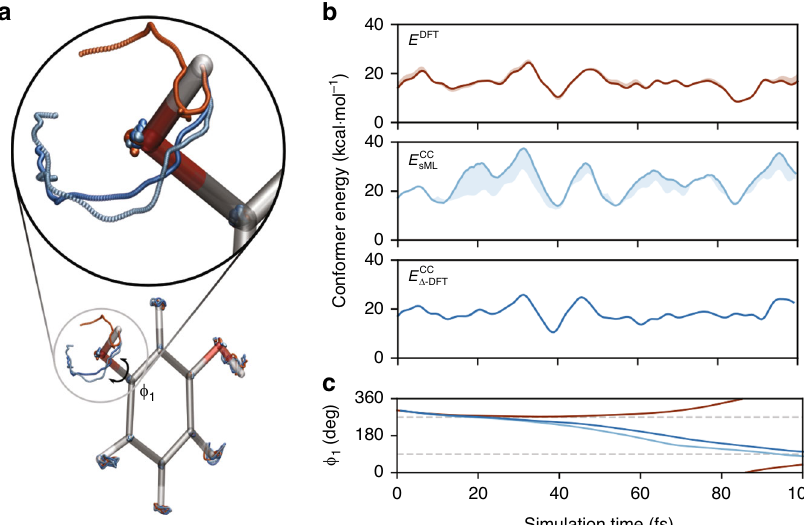
Fig. 3 Resorcinol dynamics from an initial condition near a conformational change. a The atomic positions explored during 100 fs NVE MD trajectories ½ n DFT (cid:3) with RESPA-corrected forces (light blue), and E CC ½ n DFT (cid:3) (blue). b The conformer energy along each run with standard DFT (dark orange), E CC sML s Δ (cid:1) DFT sML sML trajectory (solid lines), with the error relative to CC shown as a shaded line width. c The evolution of the C – C – O – H dihedral angle for each trajectory with dashed grey lines indicating the barrier between conformers. For this fi gure, all DFT calculations use PBE and all CC energies are from CCSD(T).